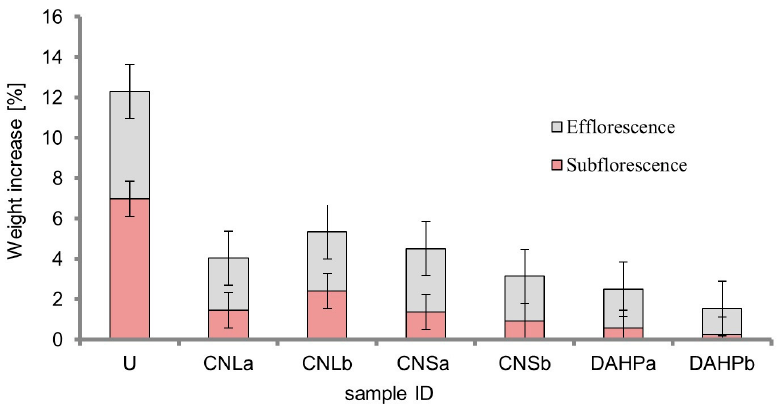
e ffl orescence and sube ffl efflorescence and subefflorescence.